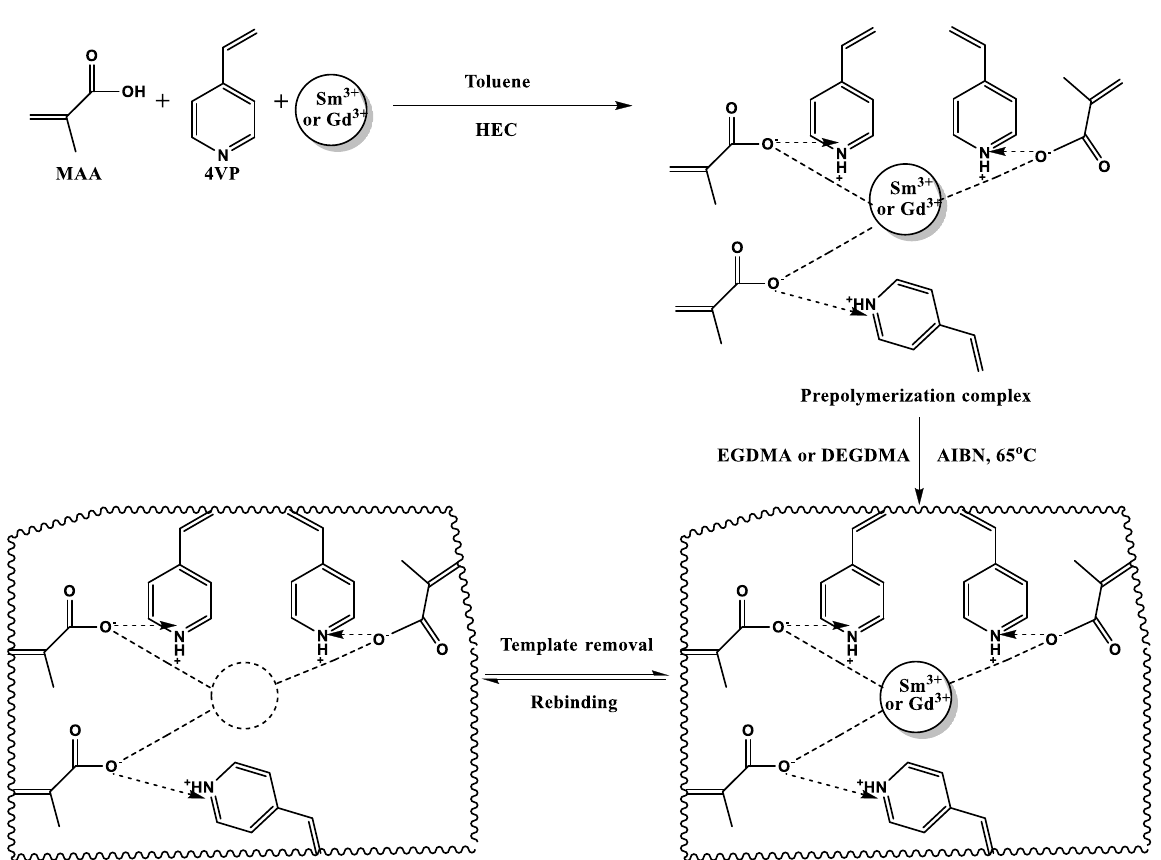
Figure 3. Scheme of the MIP synthesis.